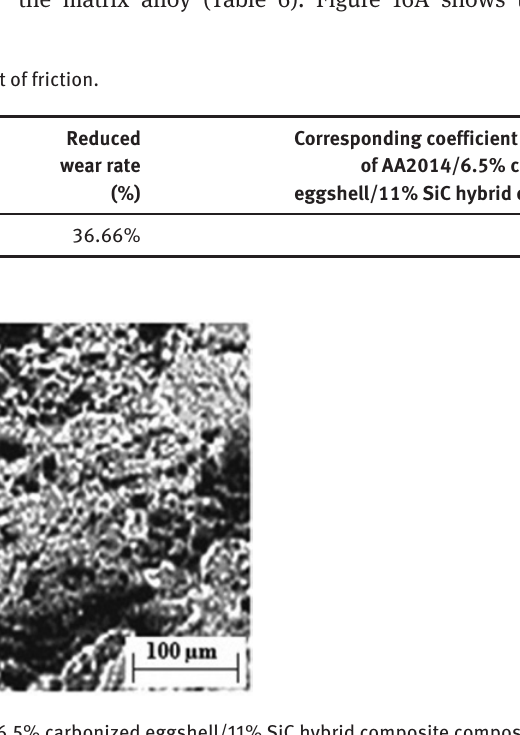
the typical microstructures of AA2014/6.5%